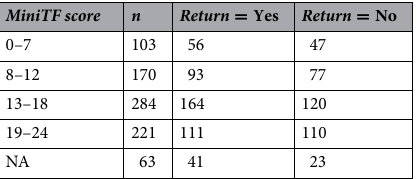
Table 5. MiniTF scores at registration for 842 users who returned after the first interruption and those that do